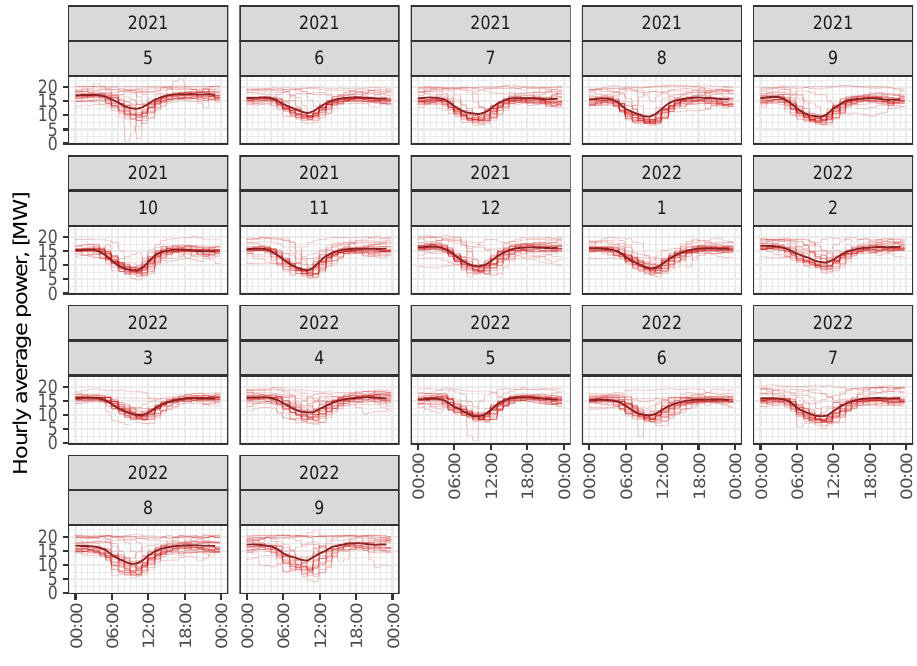
Figure 9. Average hourly heating power with assumed maximum cooling of treated wastewater by 2 K. In the second scenario, it was assumed that the treated wastewater was cooled by 7 K, but with the restriction that its temperature will not drop by more than 3 °C (Figure